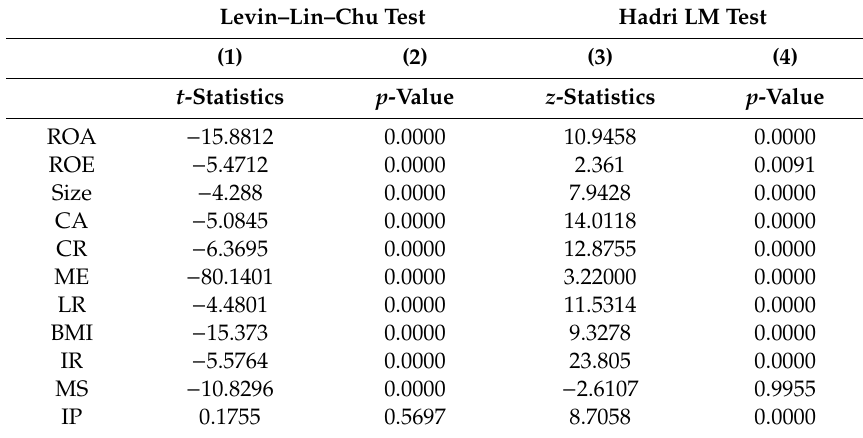
Table 3. Panel unit root